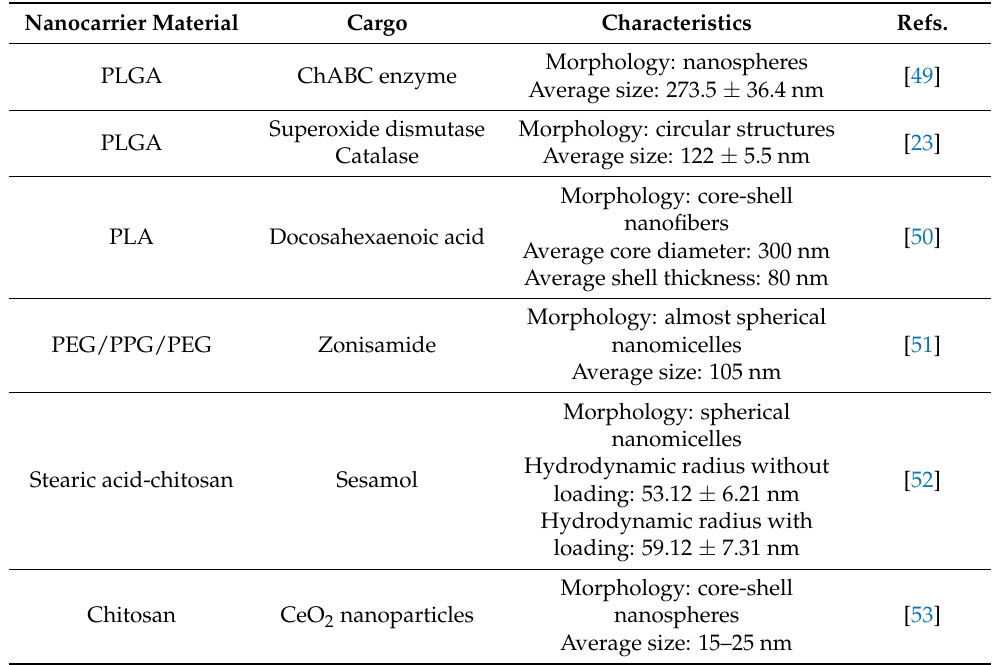
Table 3. Examples of polymer-based nanosystems for spinal cord delivery. Nanocarrier